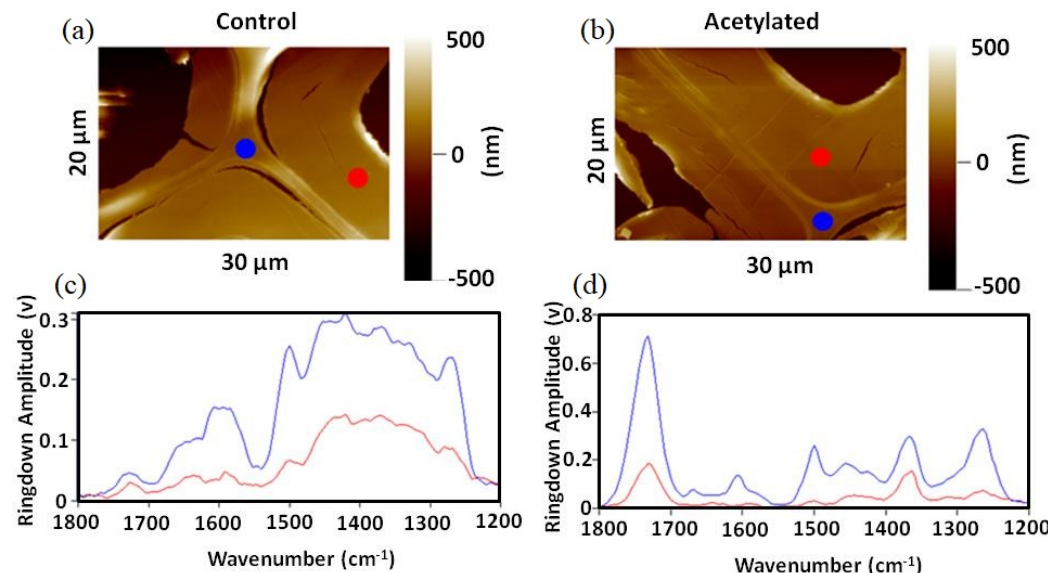
Figure 5. AFM topography images of ( a ) a control wood sample and ( b ) an acetylated wood sample, and their corresponding nanoIR spectra ( c , d ) at indicated locations. Reproduced with permission from [56]. Copyright Anasys Instruments (Now Bruker Corporation), 2012.